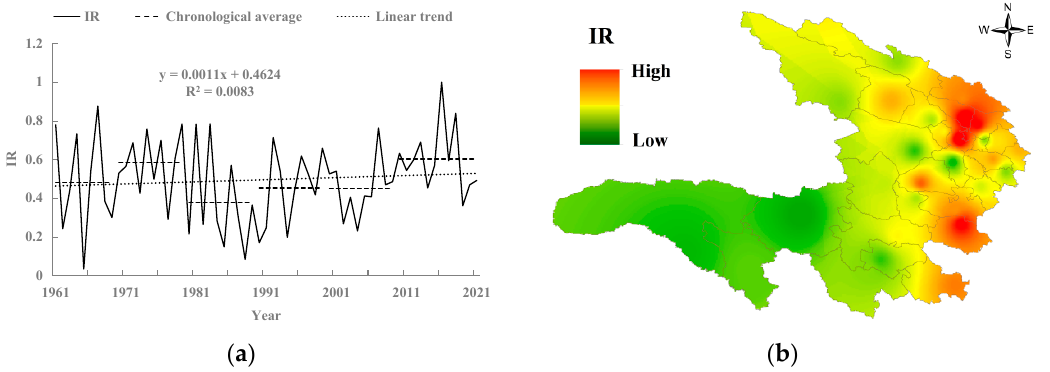
Figure 6. Changes in the risk level of rainstorm disasters under different climatic conditions in the upstream of the Yellow River Basin. ( a ) overall trend ( b ) spatial distribution.